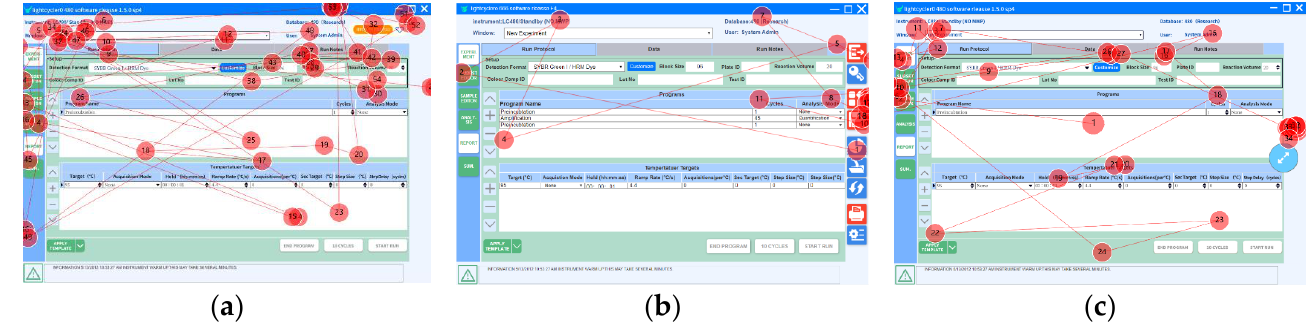
Figure 11. Three different menu bars corresponding to Schemes ( A , B , and C ), respectively. ( a ) Scheme A; ( b ) Scheme B; ( c ) Scheme C.